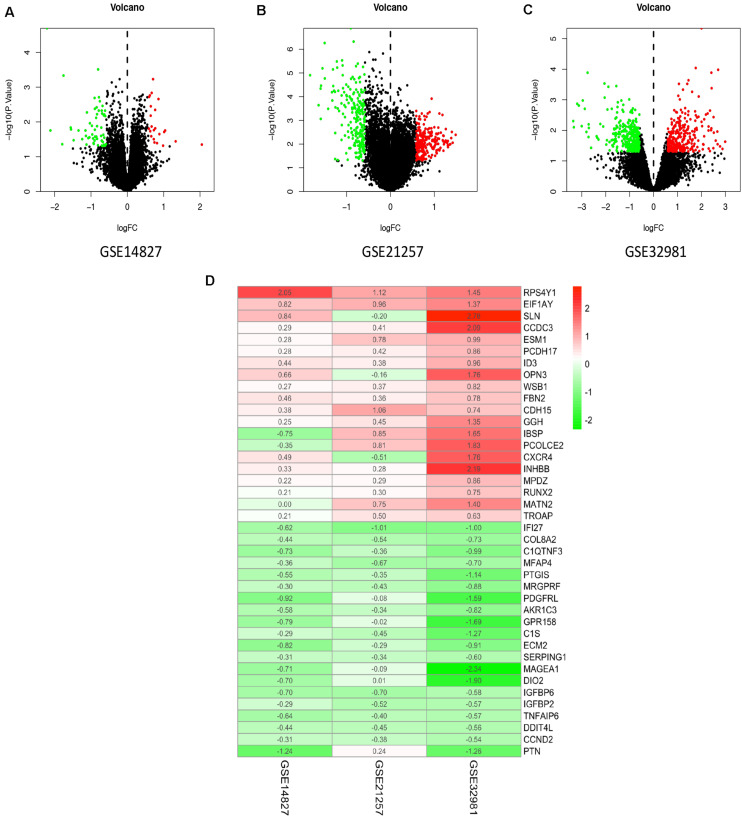
Identification of DEGs and robust DEGs. Volcano plots of the distribution of DEGs in GSE14827 (A), GSE21257 (B), and GSE32981 (C). Red and green dots represent the upregulated and downregulated genes, respectively. (D) The heatmap of top 20 upregulated and downregulated robust DEGs identified by RRA method. Red represents high expression robust DEGs, while blue represents low expression robust DEGs. DEG, differentially expressed gene; RRA, robust rank aggregation.